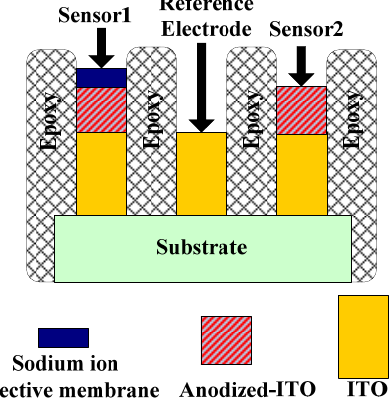
Figure 3. Cross sectional view of the differential sodium-sensing device. Sensor 1 is sodium-selective-membrane/anodized-ITO/ITO, sensor 2 is anodized-ITO/ITO, and the reference electrode is ITO.